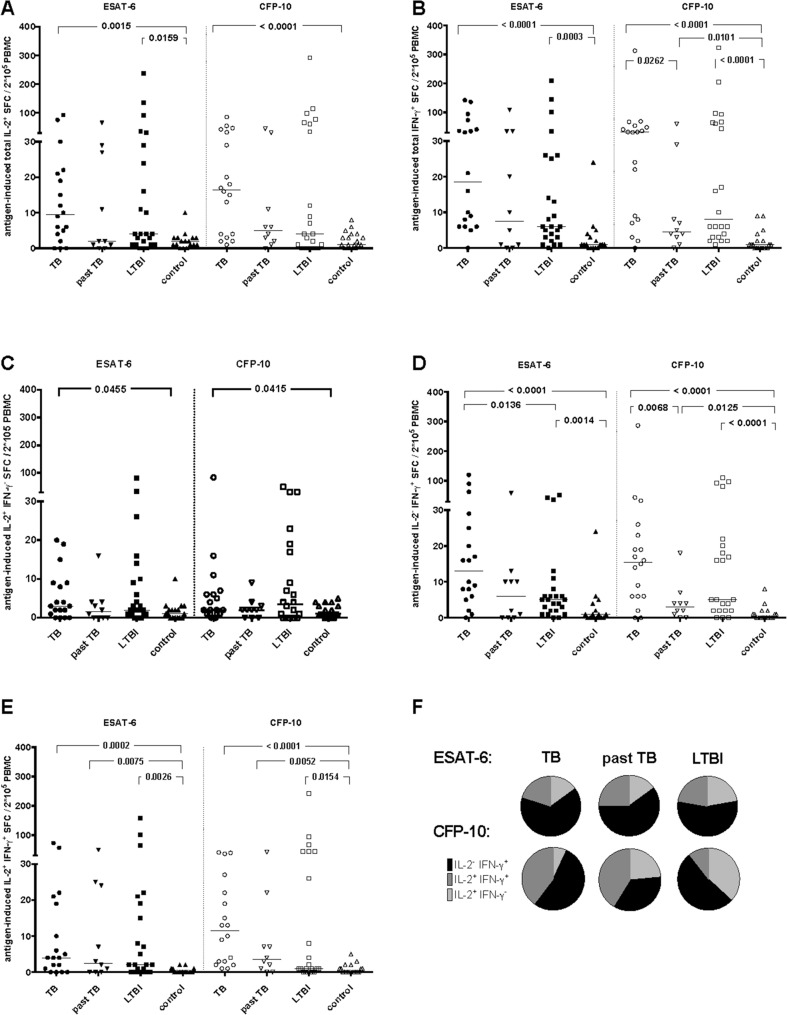
ESAT-6 and CFP-10- induced cytokine response in FluoroSpot.ESAT-6 induced cytokine immune response in 200.000 PBMCs/well in participants with active tuberculosis (TB, circle, n = 18), past tuberculosis (past TB, inverted triangle, n = 10), latent infection with M. tuberculosis (LTBI, square, ESAT-6-induced n = 24, CFP-10-induced n = 22), EliSpot-negative individuals (control, triangle, ESAT-6-induced n = 17, CFP-10-induced n = 19) was analysed. Groups had been defined according to the combination of their ESAT-6 and CFP-10 induced IFN-γ EliSpot-IGRA test result and clinical data. The number of IL-2+ (A), INF-γ+ (B), IL-2+ INF-γ- (C), IL-2- INF-γ+ (D) and IL-2+ INF-γ+ (E) spot-forming cells (SFC) were enumerated by FluoroSpot. (F) Mean proportion of ESAT-6 (top row) and CFP-10 (bottom row) -specific cytokine secreting cells for individuals with tuberculosis, past tuberculosis and LTBI are depicted as pie charts (light grey = IL-2+ INF-γ-, black = IL-2- INF-γ+ and dark grey = IL-2+ INF-γ+ secreting cells). Mann-Whitney U-test for non-parametric data was used for comparative analysis. A p-value of <0.05 was considered significant.